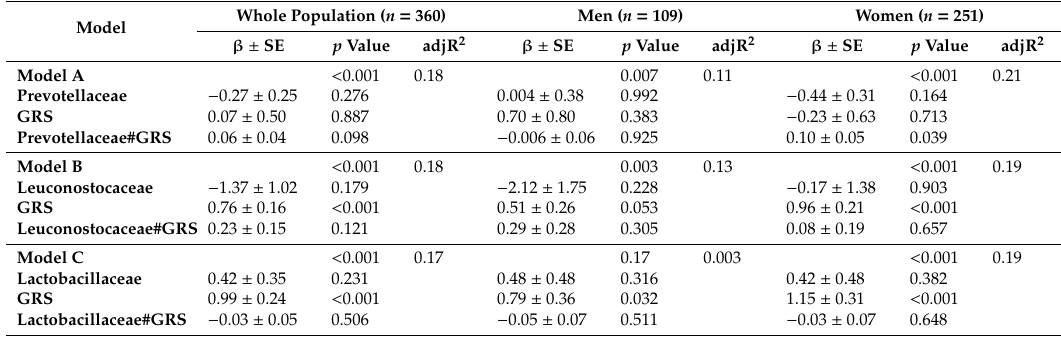
β represents changes in outcomes for the increasing number of units of BMI in the whole population and separating by sex; SE: standard error. Regression was adjusted for age, sex, physical exercise and energy intake excepting models stratified by sex in which the gender was not